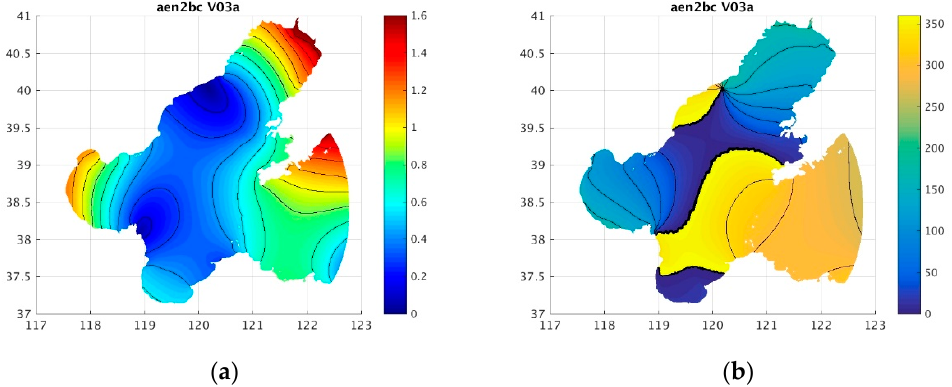
Figure 3. M 2 co-amplitude lines (m) ( a ) and co-phase lines ( o ) ( b ) in the Bohai Sea, generated with initial boundary condition and astronomical forcing.